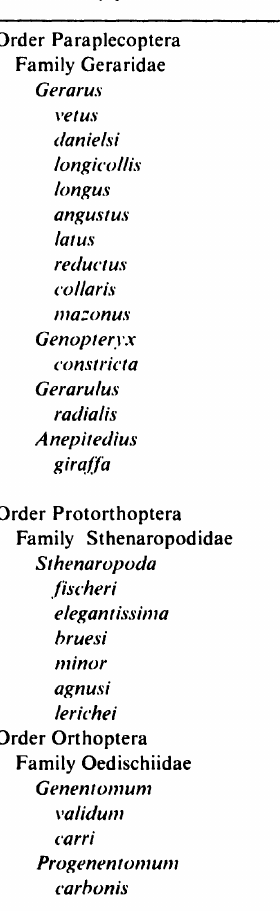
Classification proposed by Burnham in this